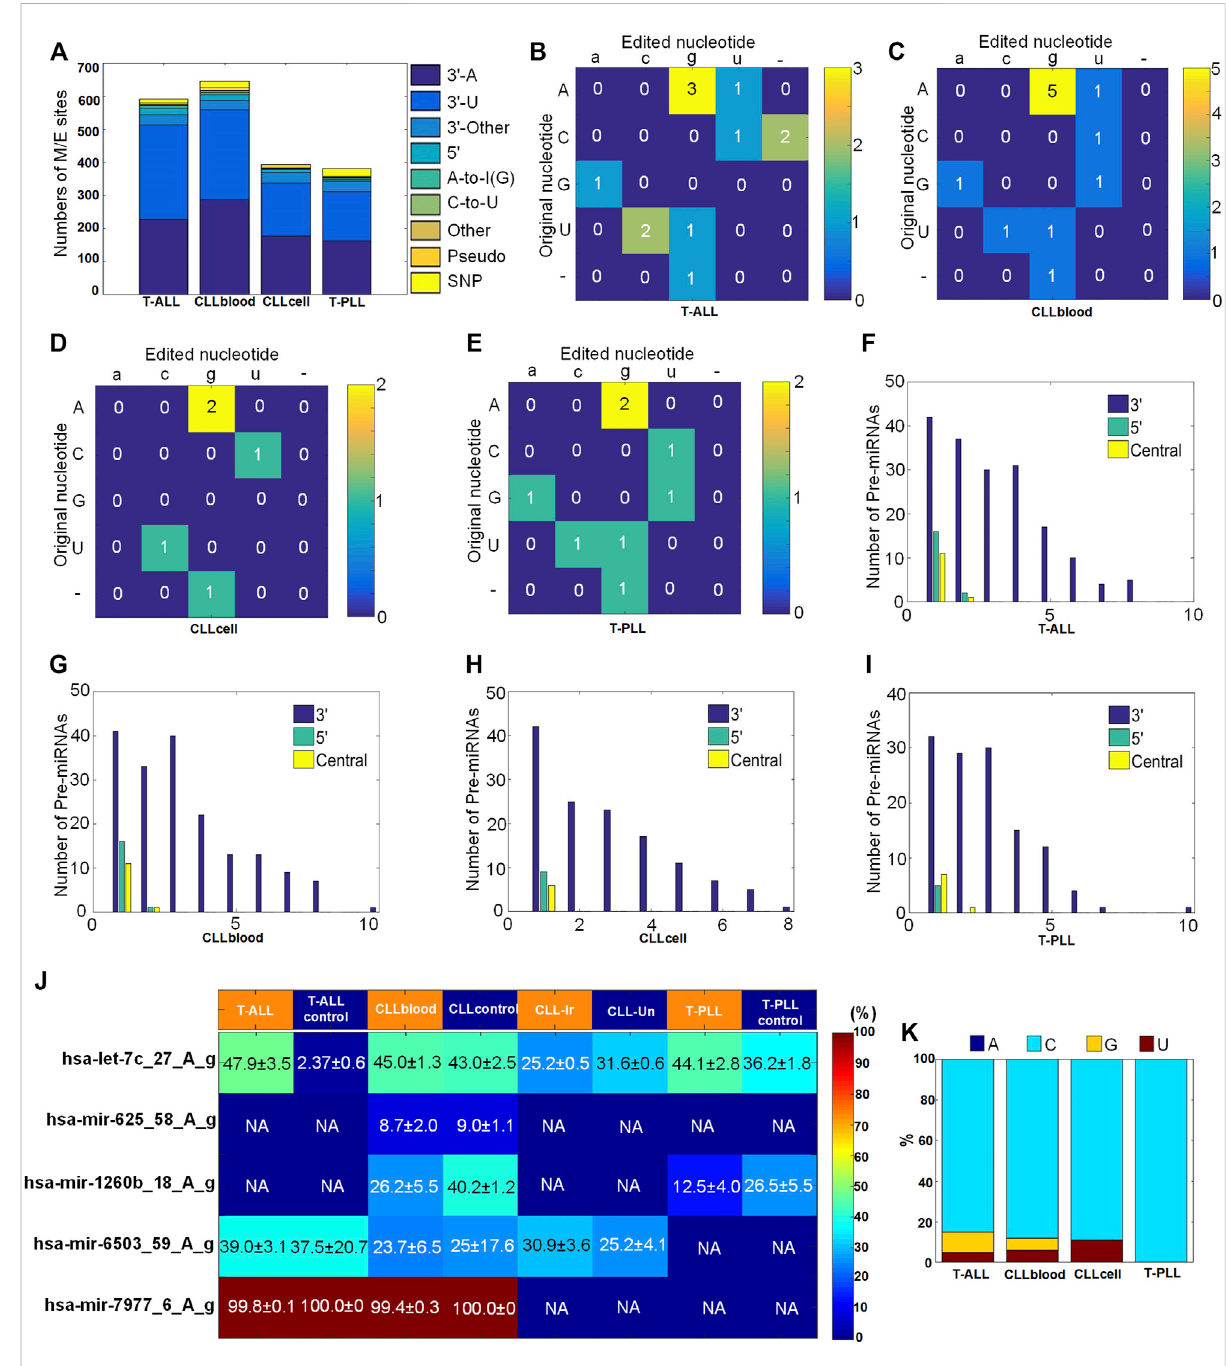
FIGURE 1 Summary of miRNA M/E sites identi fi ed in three subtypes of leukemia (A) The numbers of different types of miRNA M/E sites with signi fi cant editing levels in the selected samples. (B – E) The numbers of different types of editing sites in the central regions of miRNAs in T-ALL, CLLblood, CLLcell, and T-PLL (F – I) The numbers of pre-miRNAs with editing events at the 3 ′ -end, 5 ′ -end and central regions of mature miRNAs in T-ALL, CLLblood, CLLcell, and T-PLL, respectively (J) The editing levels of A-to-I editing sites in different subtypes of leukemia. CLLcell was divided as CLL-IrandCLL-Un.Thevaluesinthematrixaremeanvalues±standarderrorsofthemeans. “ NA ” indicatesnotavailablebyusingthecriteriathatthe M/E sites have signi fi cant editing levels in at least 20% samples selected. (K) The percentages of different types of nucleotides in 5 ′ -editing sites identi fi ed in the selected